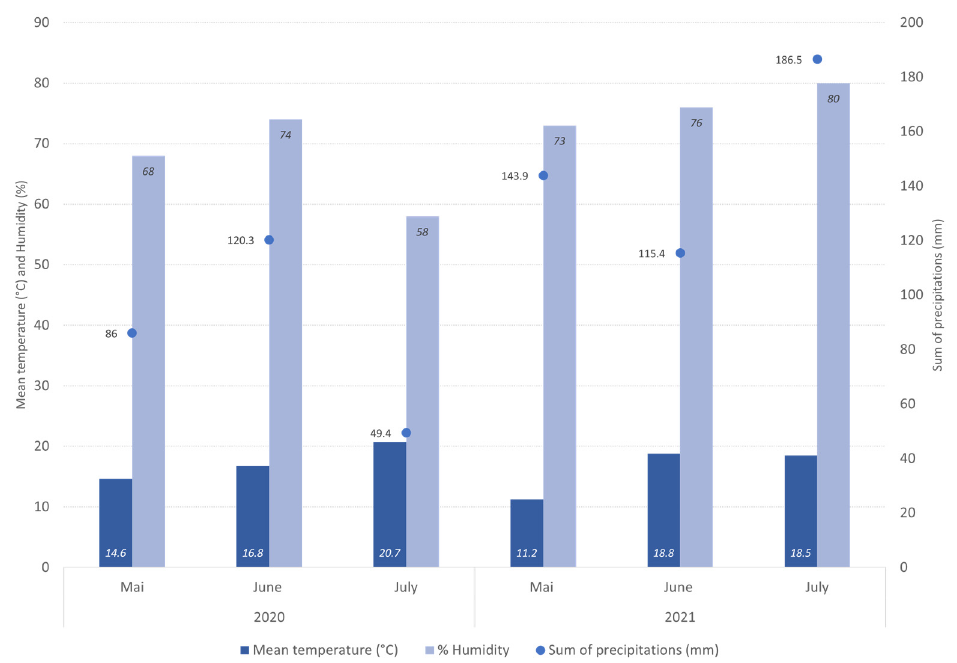
Figure 2. Average temperature, percentage of humidity, and total precipitation in Canton Vaud (Switzerland) for the months of May, June, and July of the years 2020 and 2021 (data from Agrome- teo.ch, station Arnex-sur-Orbe).